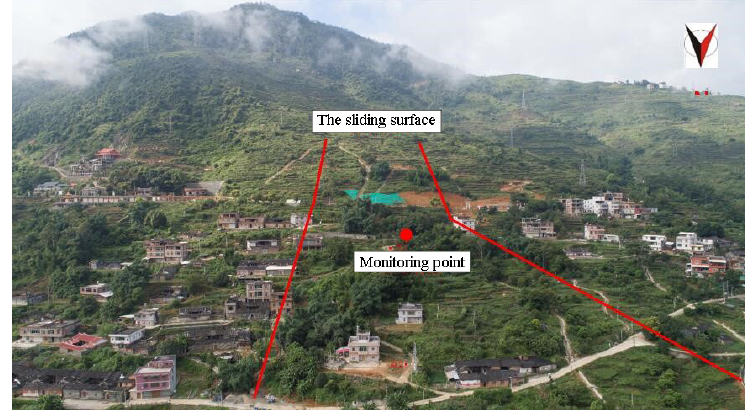
Figure 4. Landslide scope and monitoring point layout.